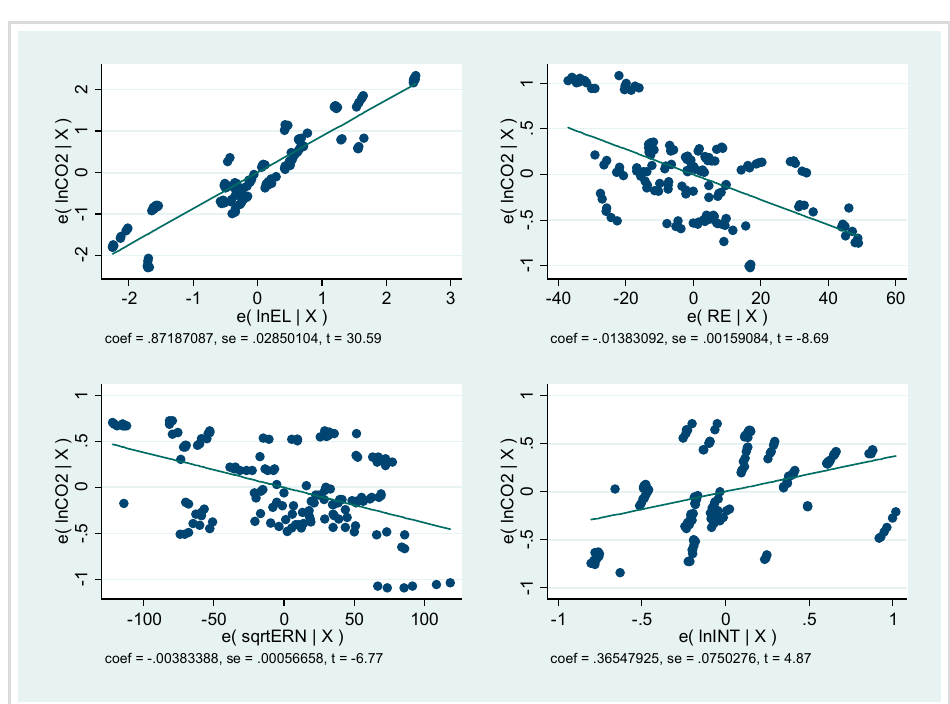
Figure 2. Test of the linearity of the relationship between the dependent and independent variables